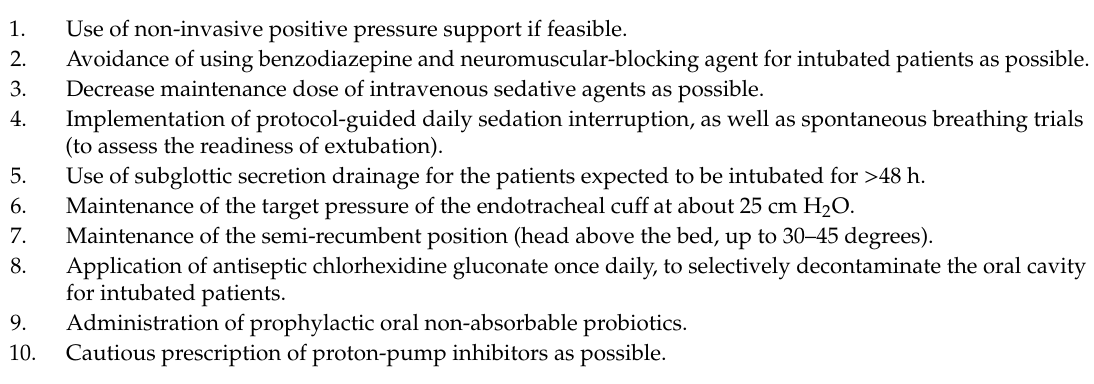
Table 5. Measures of preventing the development of nosocomial pneumonia apart from